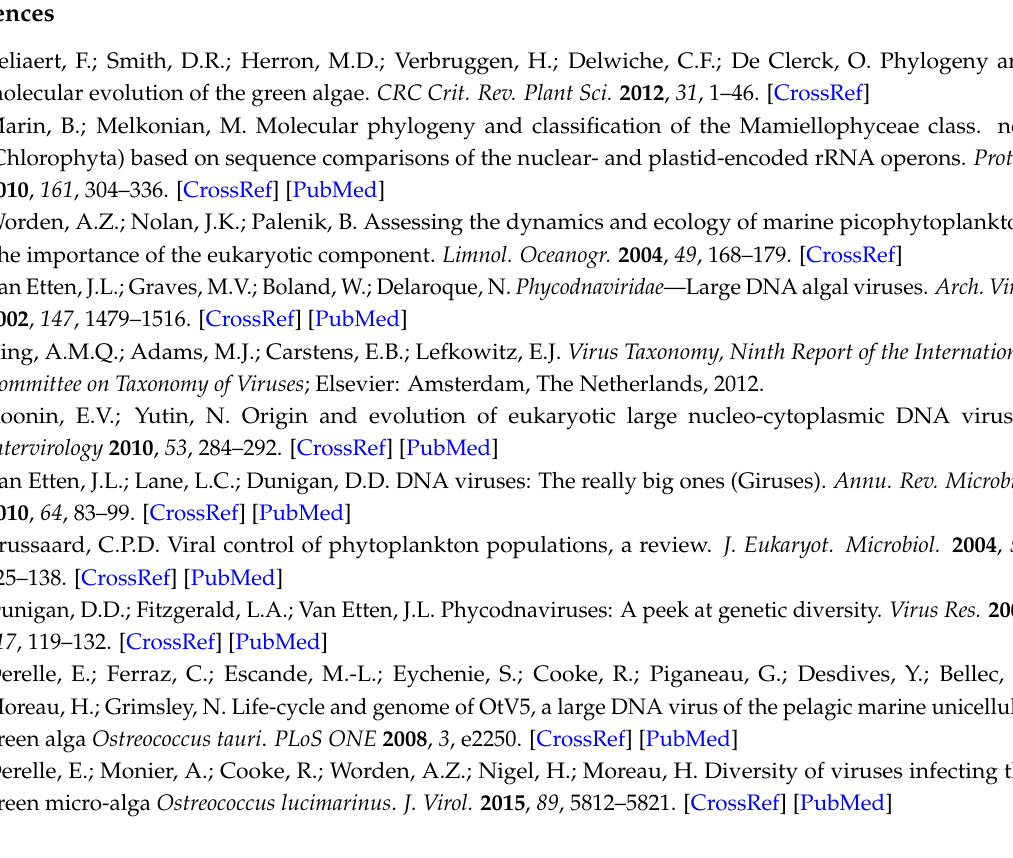
Figure S1: Venn diagram of the CDS of four prasinoviruses, based on clusters by 0.5 amino-acid identity, Table S1: Sampling details and in situ conditions for environmental amplicon sequences from Jericho Pier, Point Atkinson, Juan de Fuca Strait, and Saanich